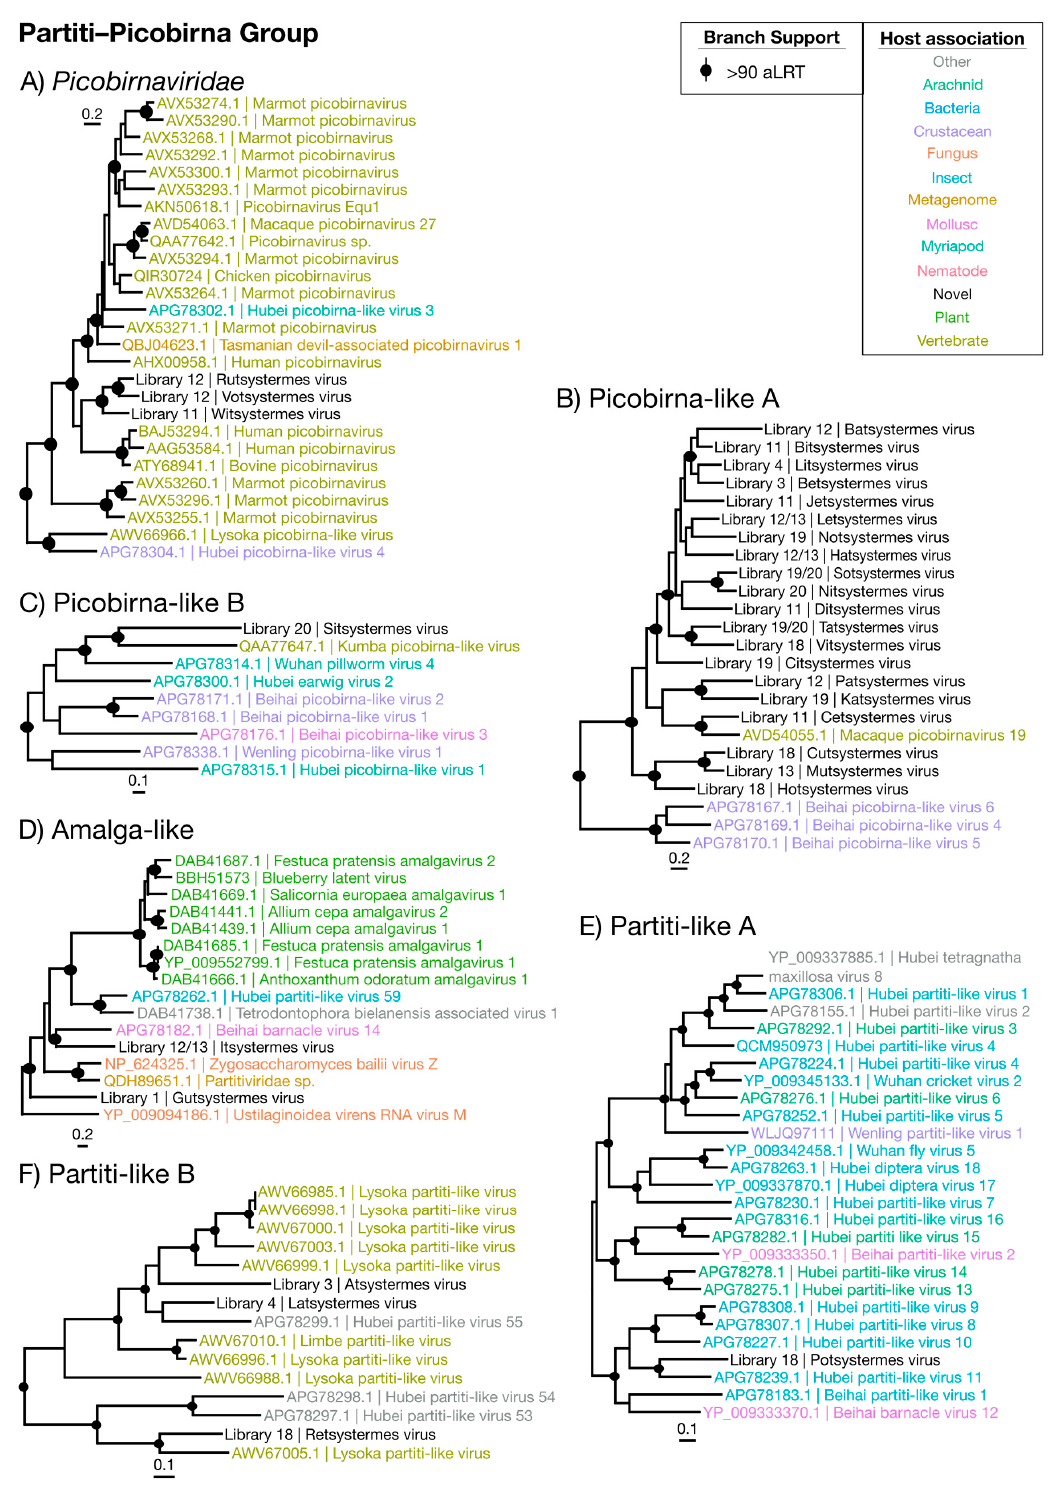
Figure 7. Phylogenetic trees of the viruses newly discovered here and their relatives in the Partiti–Picobirna group. Newly identified viruses are labeled with black text in the format “<Library # | Virus name>”, while related viruses are colored by their host association and are labeled in the format “<Replicase protein accession> | <Virus name>”. Black dots at tree nodes indicate high branch support (aLRT > 90).